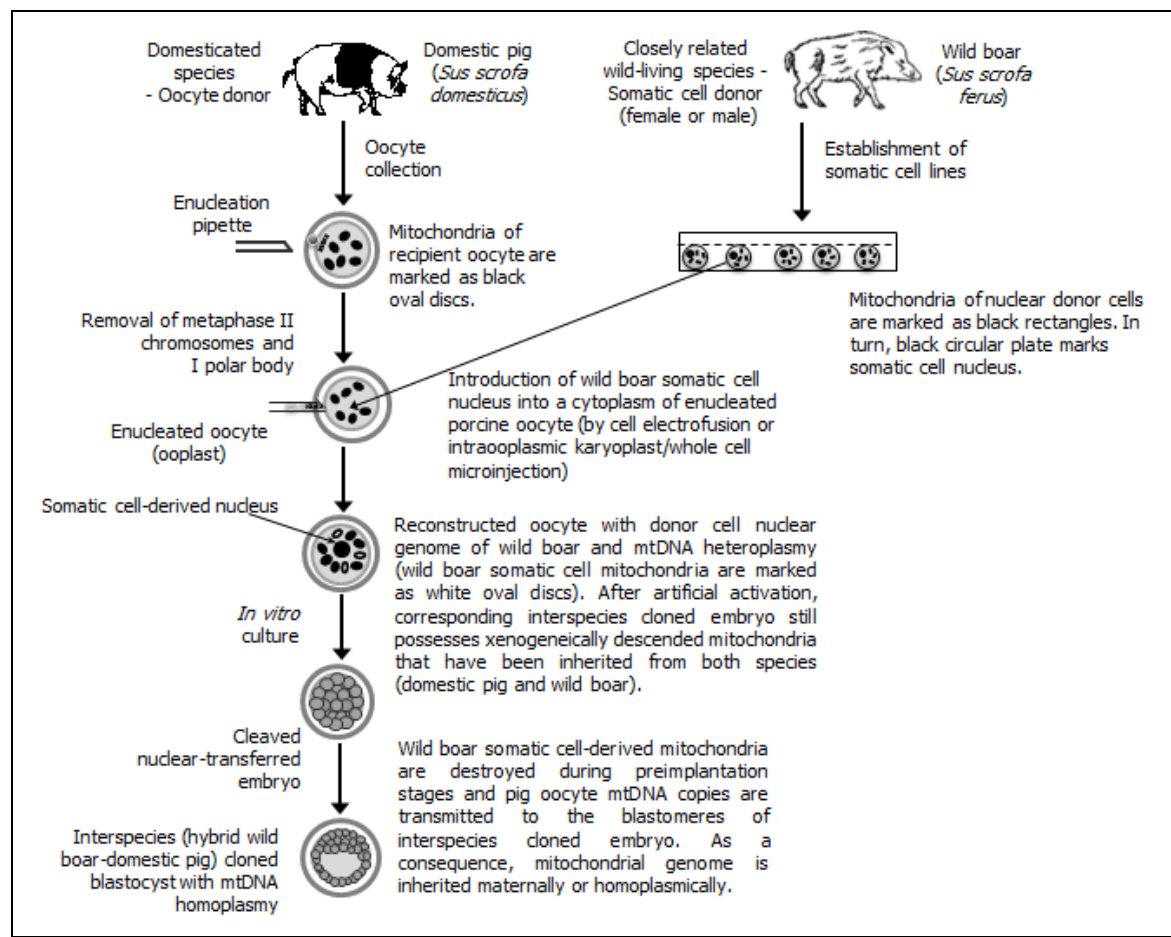
Figure 2. Interspecies (intrafamily and intragenus) somatic cell cloning, in which nuclear donor cells and recipient oocytes are recovered from phylogenetically consanguineous species (i.e., wild boar and domestic pig, respectively). Porcine oocyte-derived mitochondrial DNA (mtDNA) is inherited predominantly during preimplantation development of interspecies (wild boar → pig) cloned embryos, leading to intracellular mtDNA homoplasmy at the blastocyst stage.